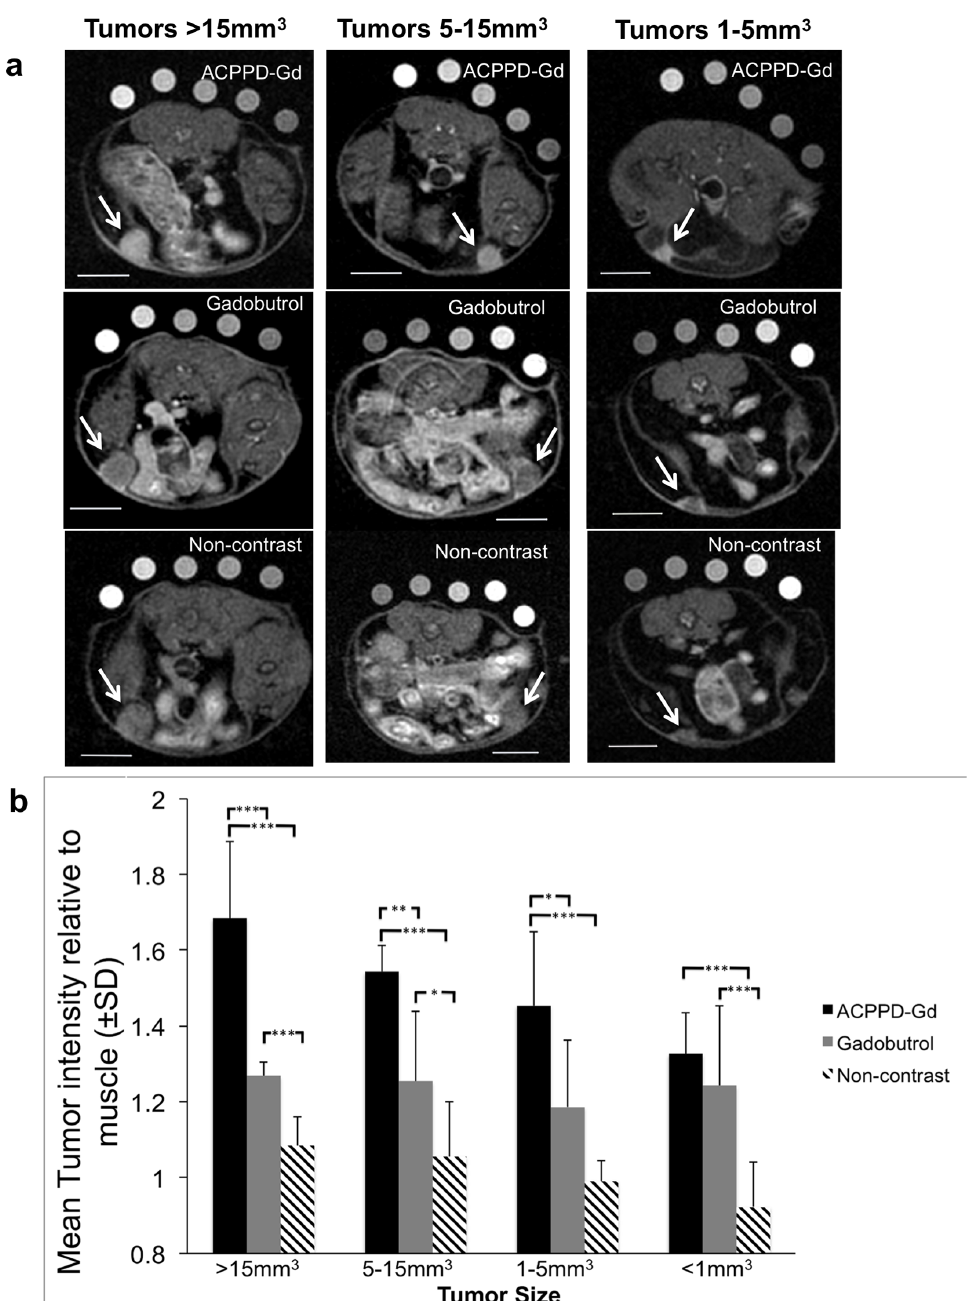
Fig 3. Degree and pattern of enhancement as a function of tumor size. a , Representative axial fat-saturated T1w MR images of mice given ACPPD-Gd (top row) and others imaged before (bottom row) and after gadobutrol (middle row) with comparable size tumors shown with the same window and level. Note that while ACPPD-Gd produced homogenous diffuse tumor enhancement (arrows), gadobutrol enhanced predominantly the tumor rim. Scale bar in each image = 5mm. b , Bar graph shows mean tumor enhancement ± SD for each contrast group as a function of tumor size groups. * indicates p < 0.05, ** p < 0.01, *** p <